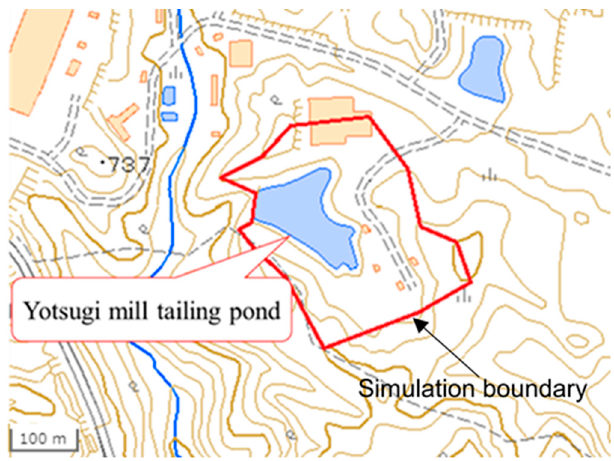
Figure 3. The boundary of the simulation area (the red line), which was set on the ridges surrounding the Yotsugi mill tailings pond.